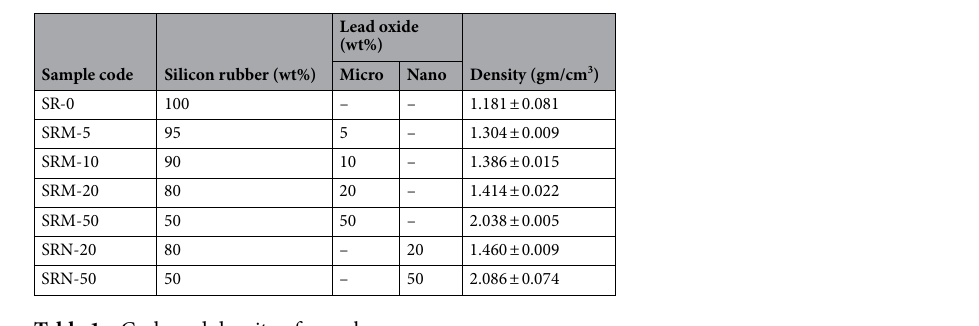
Table 1. Code and density of